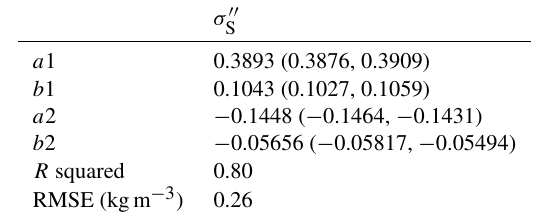
Table 2. Parameters and goodness of Fourier fit (Fig. 4). σ (cid:48)(cid:48) ( doy ) = doy ) .